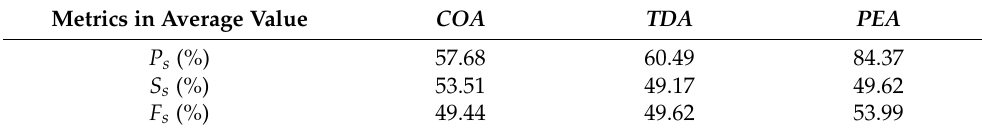
Table 7. General results comparison of REDD-based NILM for traditional approaches.